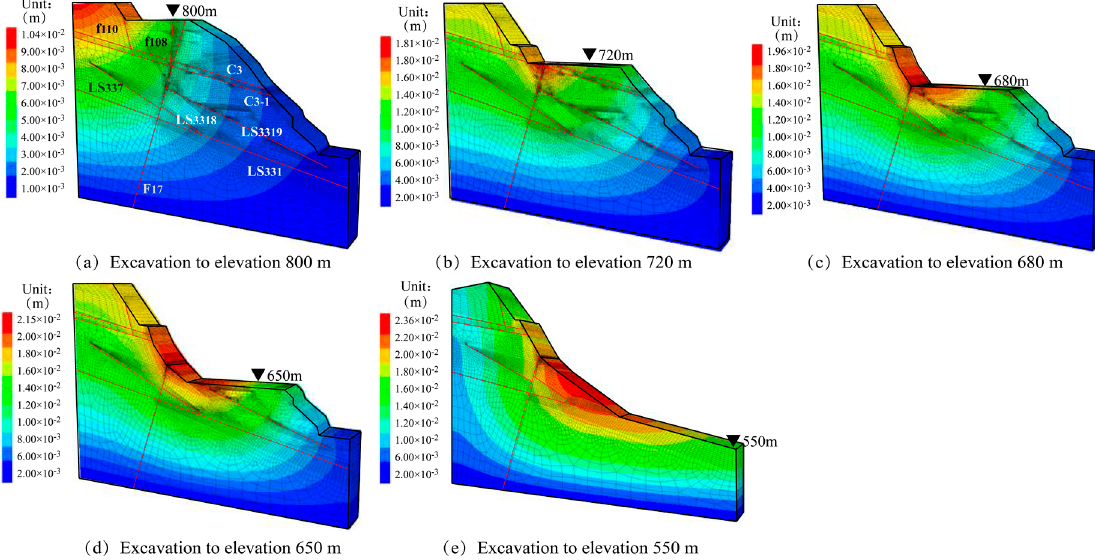
Figure 11. Slope displacement nephogram considering the effect of MS event destruction during excavation at an elevation of ( a ) 800 m, ( b ) 720 m, ( c ) 680 m, ( d ) 650 m, and ( e ) 550 m.